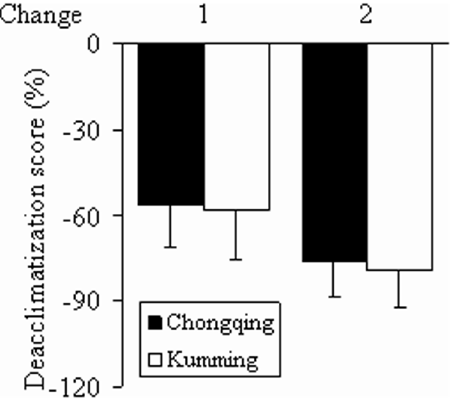
Figure 2. Rates of change in symptom scores. Data are presented as mean 6 SD. Symptom scores recorded on the 3 rd day after return to low-altitude areas served as baseline values. Rate of change 1=(score on 50 th day-score on 3 rd day)/score on 3 rd day 6 100%; rate of change 2=(score on 100 th day-score on 3 rd day)/score on 3 rd day 6 100%. Rates of change 1 and 2 showed no significant difference between the Chongqing and Kunming groups ( P . 0.05).